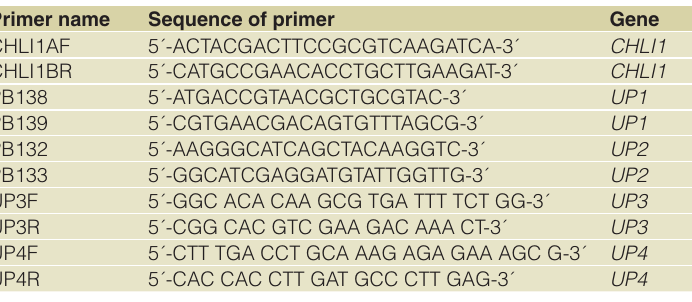
Table 2. List of primers used for amplifying CHLI1 and four neighboring genes downstream of CHLI1 . These primers were used to generate the data in Figure 6A. The gene loci in Phytozome (http://www.phytozome.net/) are: CHLI1 (Cre06.g306300), UP1 (Cre06.g306250), UP2 (Cre06.g306200), UP3 (Cre06. g306150) and UP4 (Cre06.g306100).